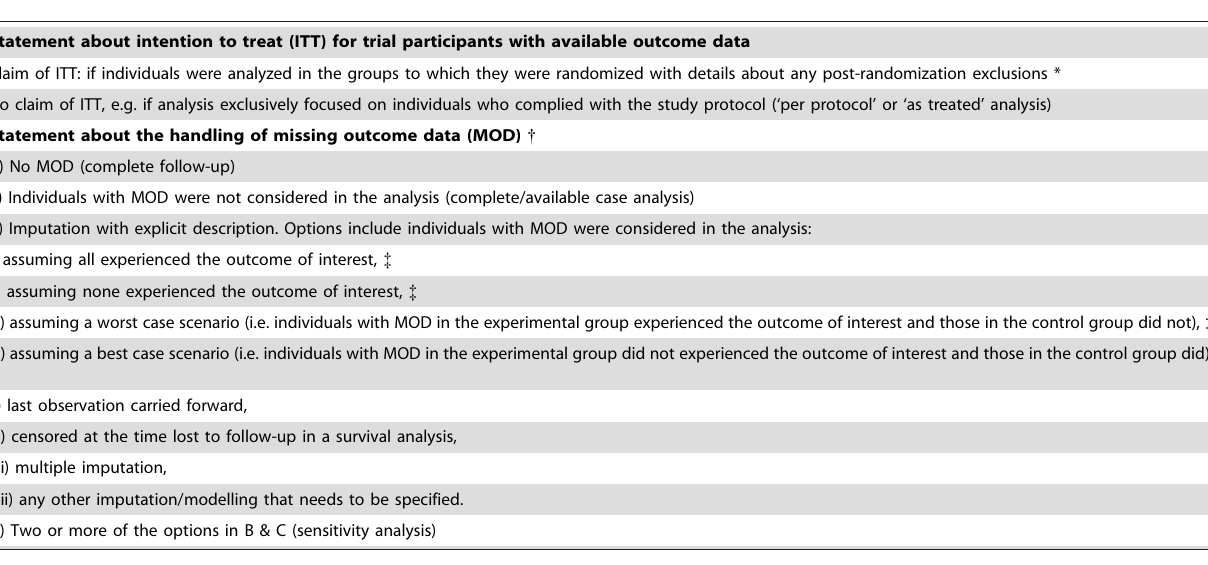
Table 3. Essential components to report in randomized clinical trials with respect to the analysis.